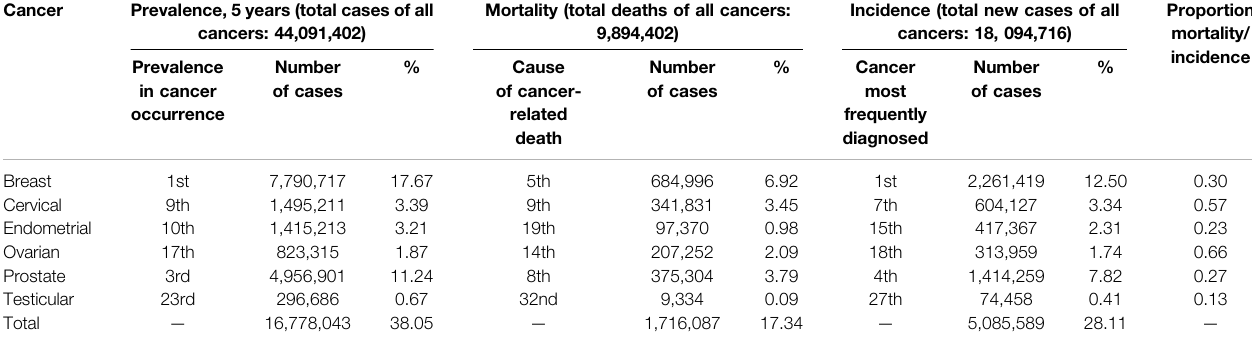
TABLE 1 | Incidence, mortality, and prevalence of male and female reproductive cancers worldwide in 2020. Cancer Prevalence, 5 years (total cases of all